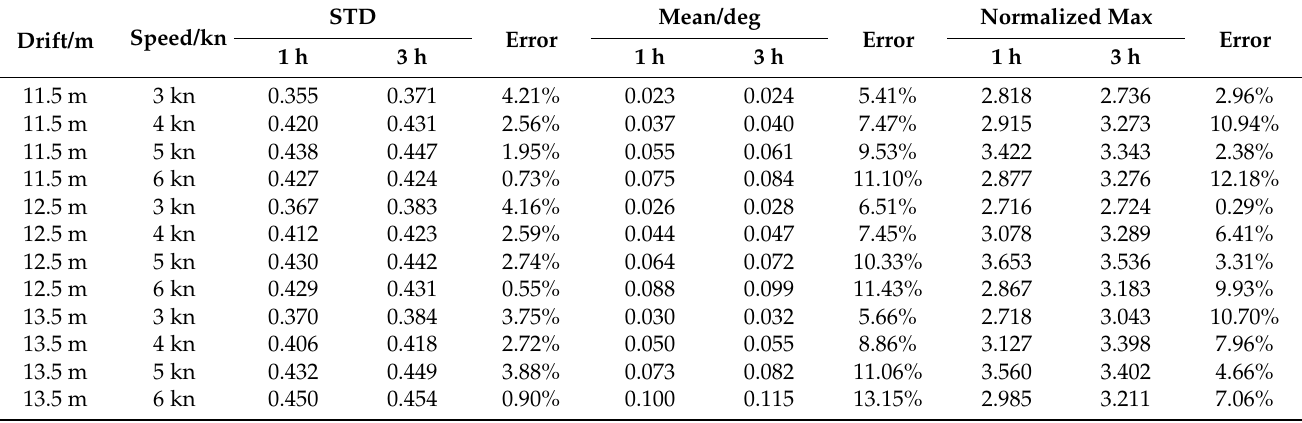
Table 5. Pitch at different simulation times.